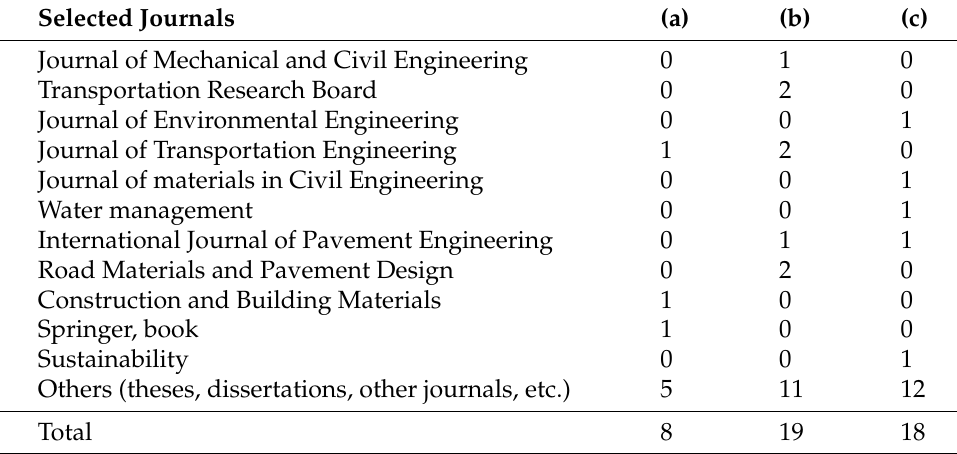
Table 1. Final selected journals together with the search keywords: a, b and